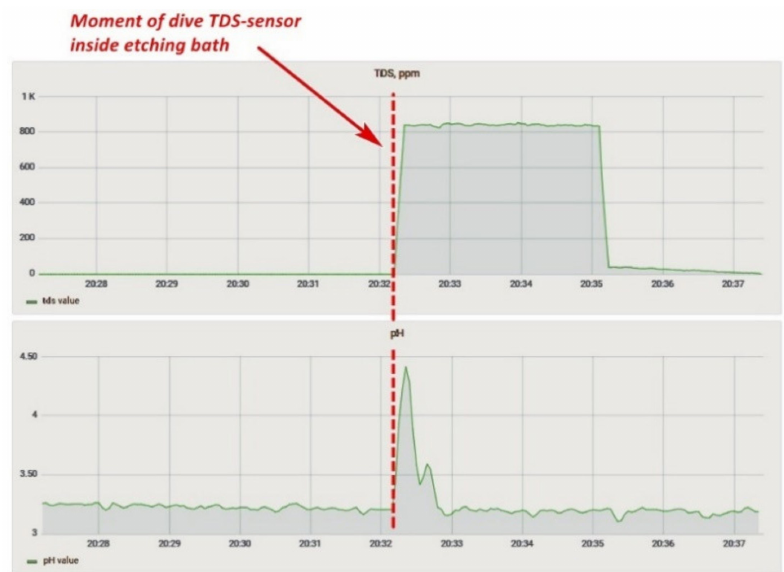
Figure 17. Influence of the TDS-sensor in the bath on the pH values.